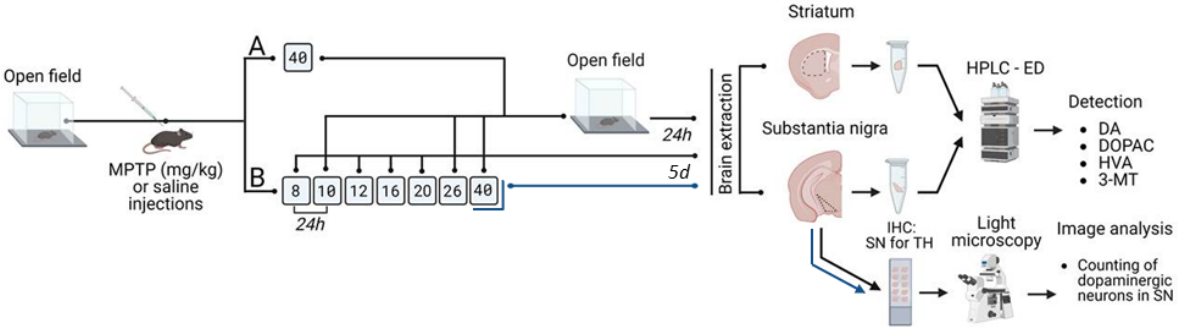
Figure 7. Design of experiments with subcutaneous administration of 1-methyl-4-phenyl-1,2,3,6- tetrahydropyridine (MPTP) to mice: ( A ) once at a dose of 40 mg/kg, ( B ) 7 times at gradually increasing doses from 8 to 40 mg/kg, with a preliminary analysis of motor behavior and subsequent analysis of motor behavior and the state of the nigrostriatal dopaminergic system 24 h after the last injection. 3-MT—3-methoxytyramine; DA—dopamine; DOPAC—3,4-dihydroxyphenylacetic acid; HVA—homovanillic acid; IHC—immunohistochemistry; SN—substantia nigra; TH—tyrosine